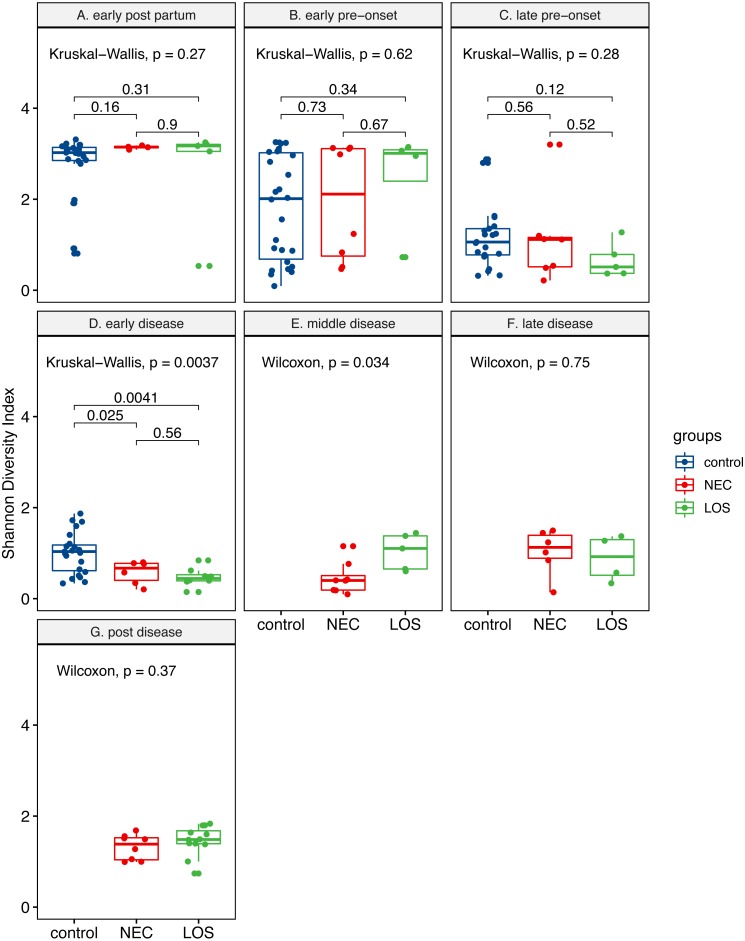
Post-partum microbiome evenness (Shannon diversity) in each time-interval.Shows microbial richness trend in stools from cases and controls. (A) Control group. (B) NEC group. (C) LOS group. The horizontal line shows median, box boundaries show 25th and 75th percentiles. Shannon index value of each stool is depicted as one dot. p values among three groups were calculated by Kruskal–Wallis test. Comparisons between two groups were calculated by the Mann–Whitney test.